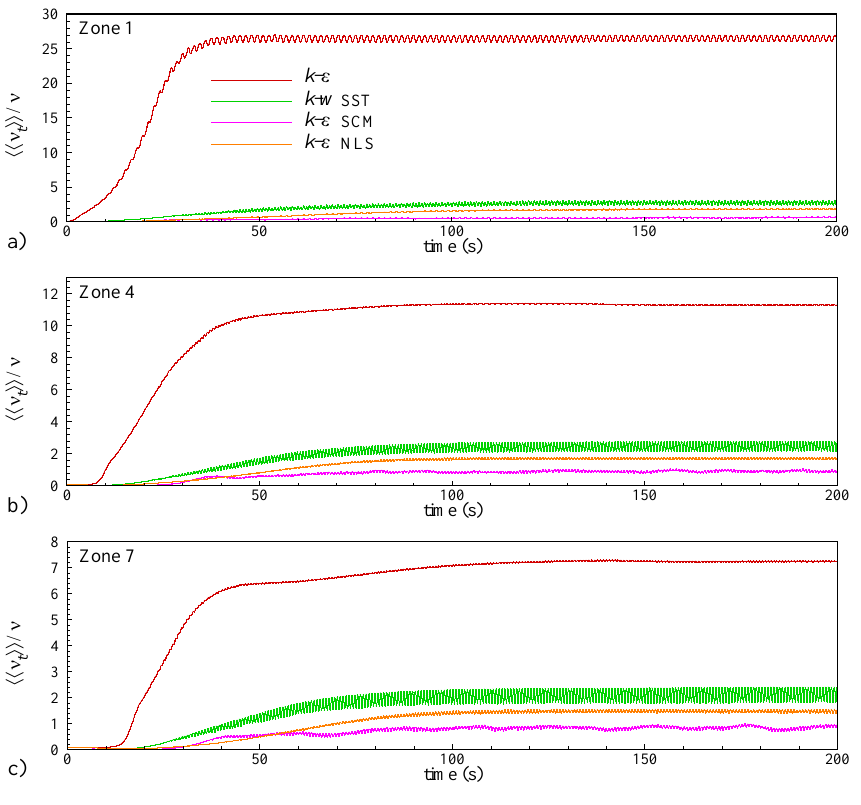
Figure 4. Time series of non-dimensional eddy viscosity (spatial average) in zone 1 ( a ), 4 ( b ), and 7 ( c ) for the wave overtopping case for the four turbulence models.